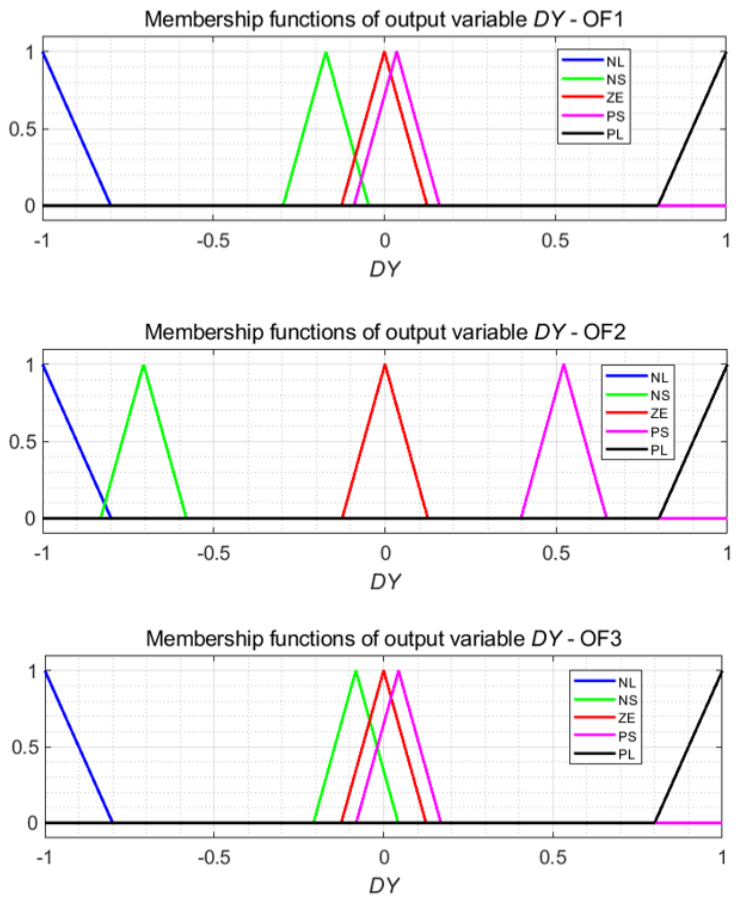
Figure 9. Velocity fuzzy PD logic controller membership functions of output variable DY after optimization with objective functions OF1, OF2 and OF3 (N: negative, ZE: zero, P: positive, L: large, S: small).